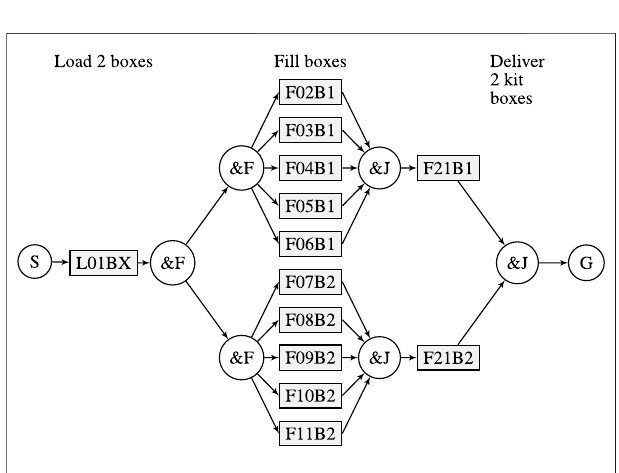
FIGURE 6 | RTSG representation of Scenario